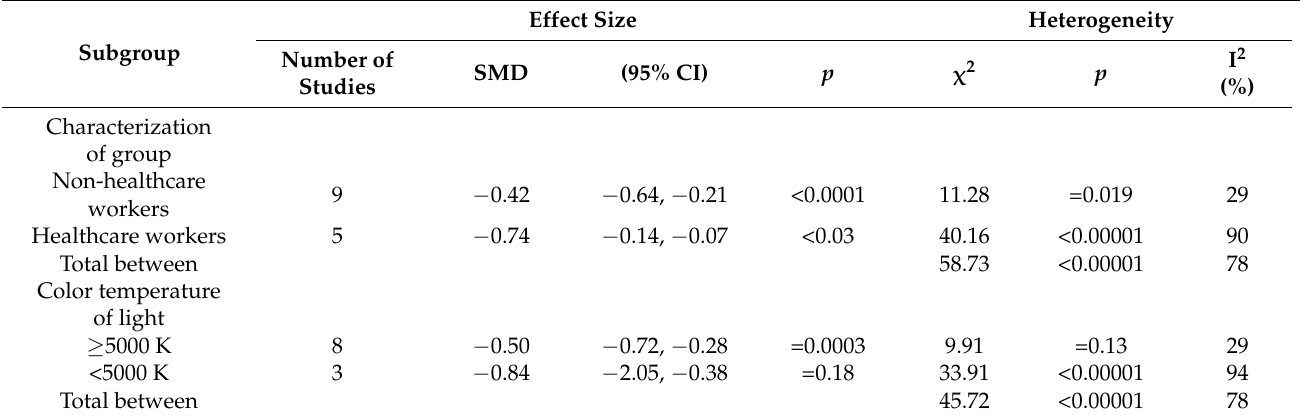
Table 2. Subgroup analysis of the efficacy of light in reducing sleepiness.